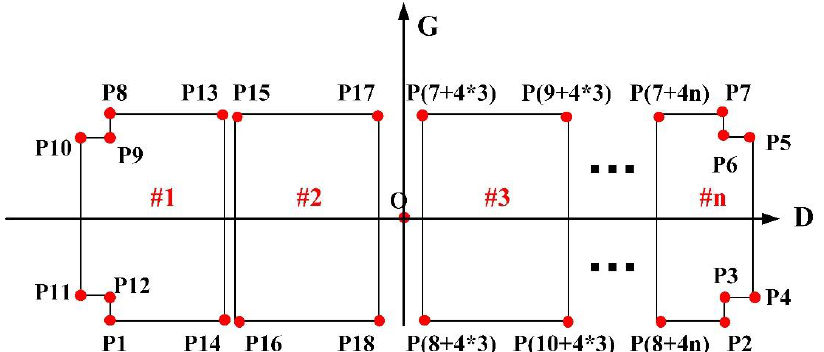
Figure 16. Coordinates of the segmented slab.